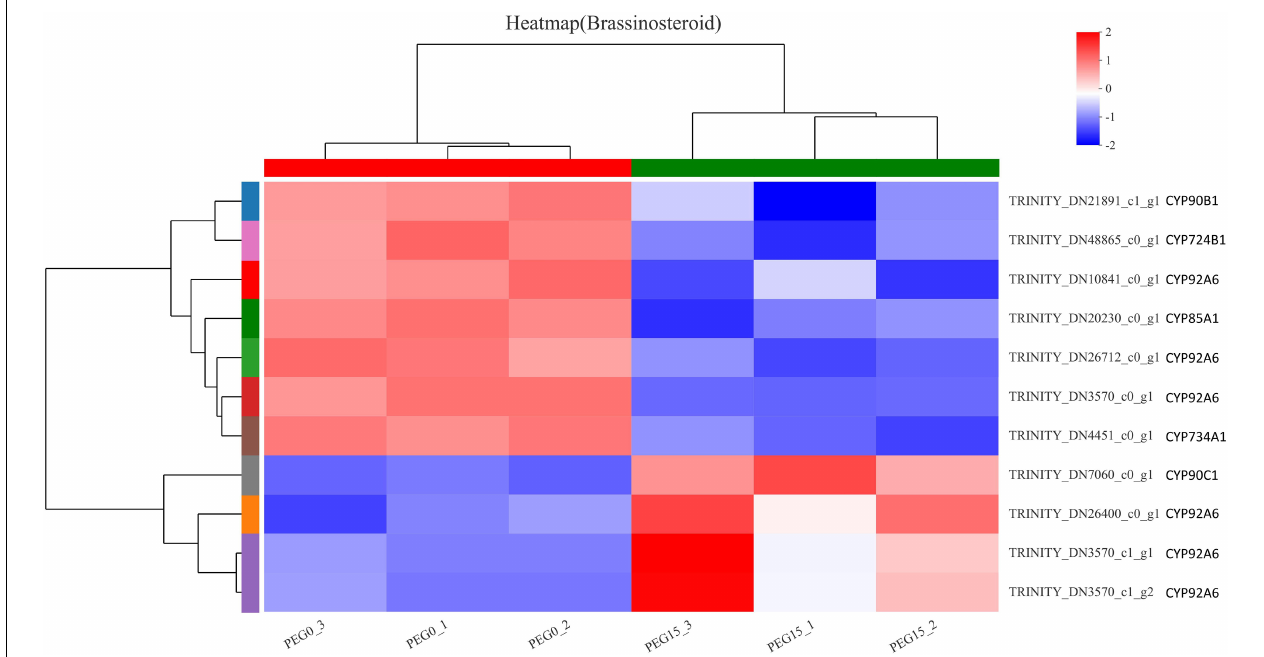
FIGURE 11 | The heat map of the DEGs involved in the “brassinosteroid biosynthesis” pathway.